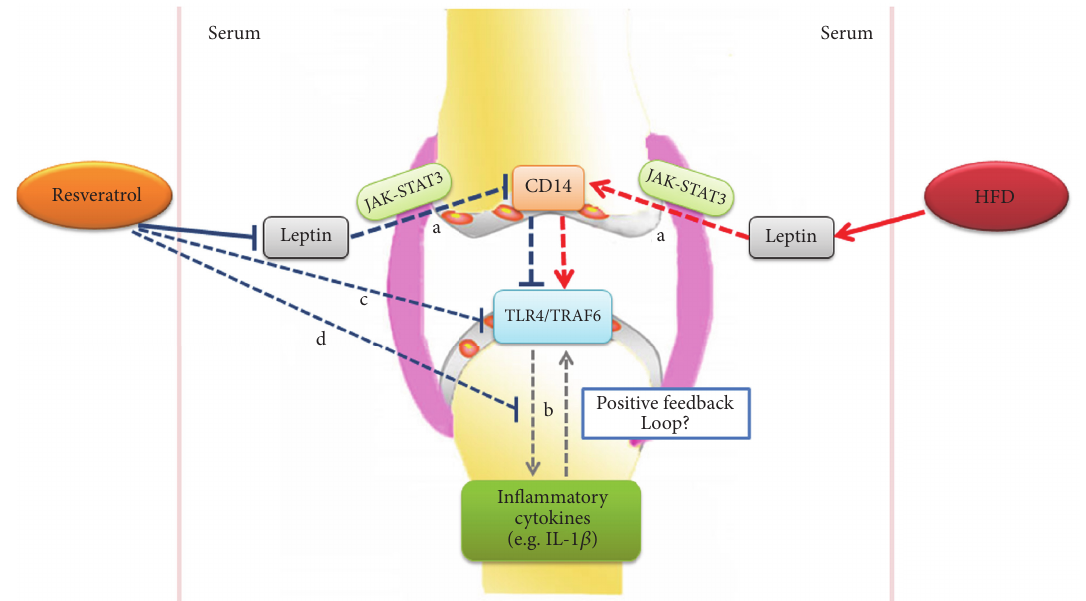
Figure 6: Schematic describing the effects and proposed response on TLR4 signaling pathway and inflammatory cytokines resulting from resveratrol treatment and HFD. HFD stimulated serum leptin level and decreased with resveratrol treatment. Leptin may upregulate CD14 via the JAK-STAT3 signaling pathway and activate CD14-dependent TLR4 pathway to induce an inflammatory response (a, dashed line). A positive feedback loop may exist between IL-1 𝛽 and TLR4 pathway (b, dashed line), and resveratrol-mediated direct (c, dashed line) or indirect (d, dashed line) inhibition of TLR4 expression in cartilage could block the IL-1 𝛽 -TLR4 pathway feedback